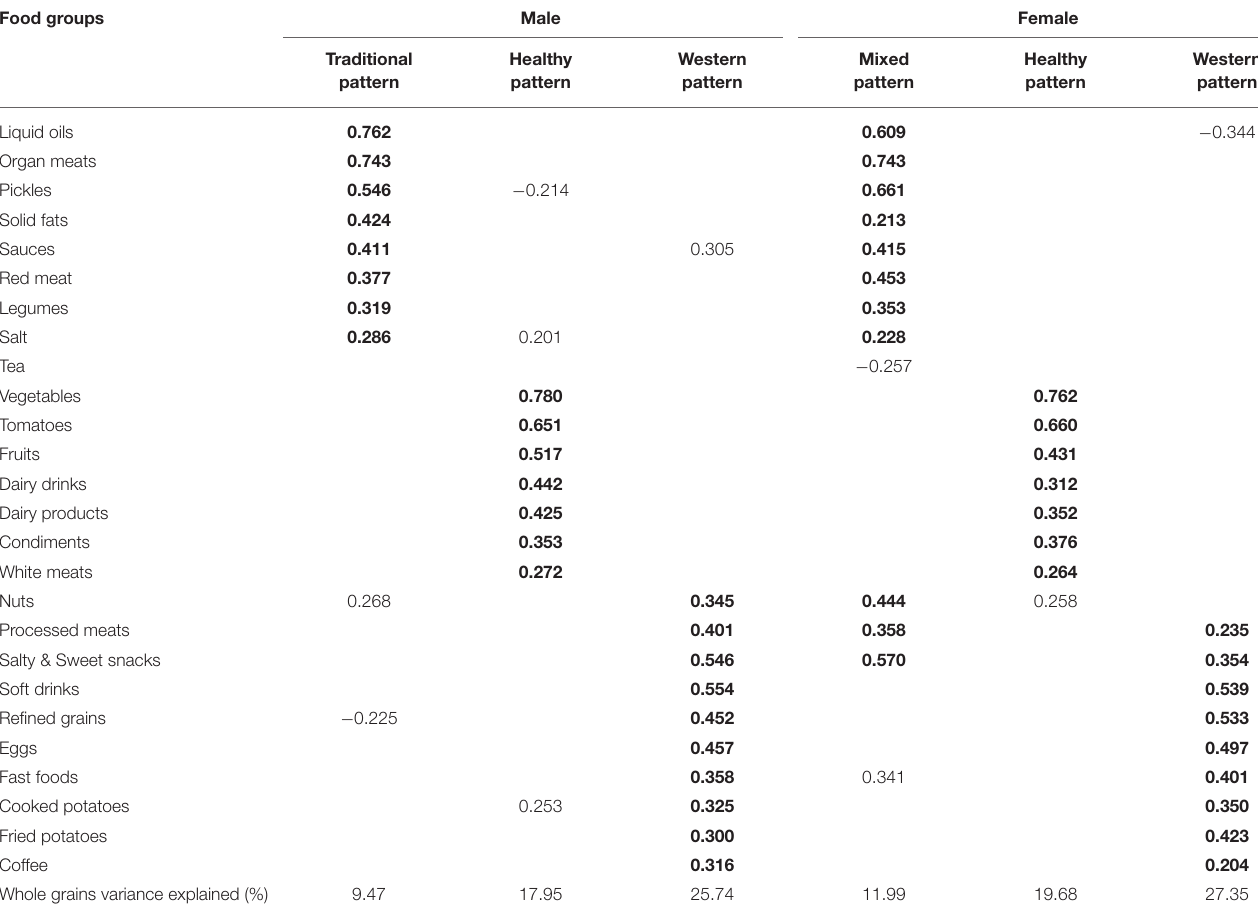
TABLE 2 | Factor loadings for dietary patterns extracted from factor analysis by gender a . Food groups Male Female